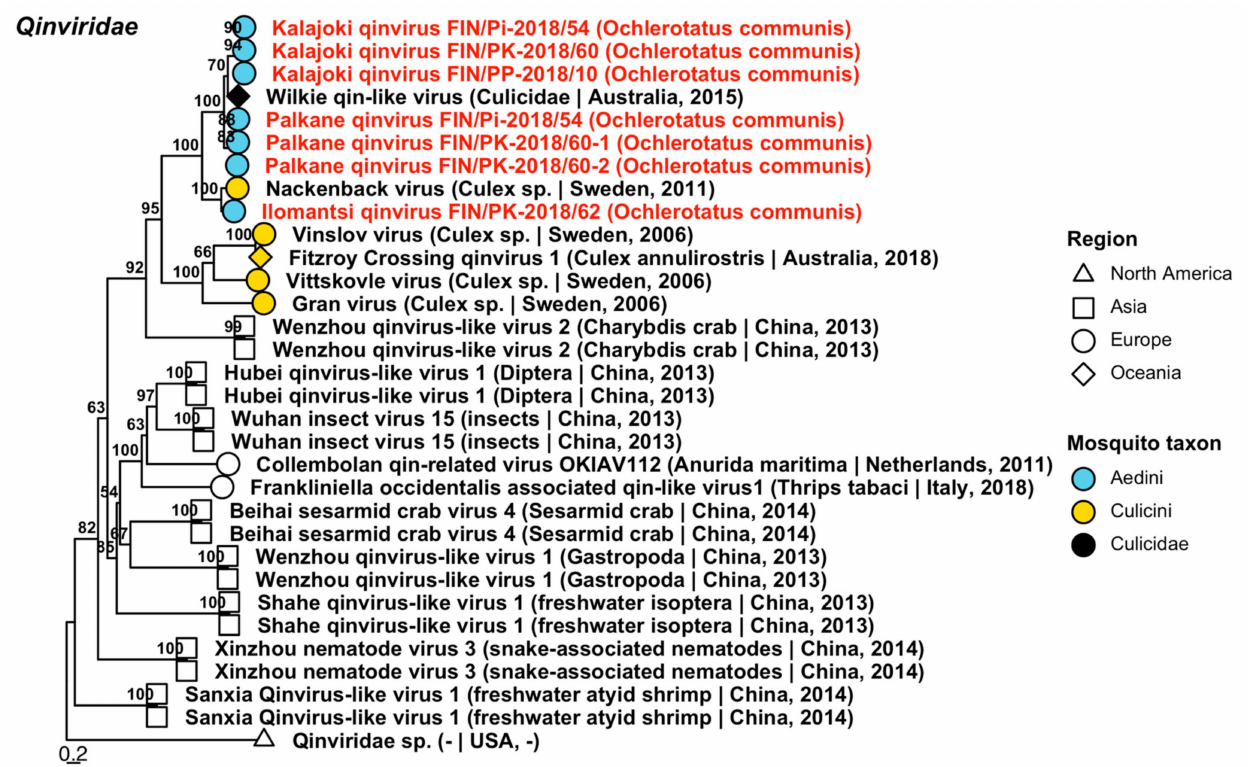
Figure 13. Maximum likelihood tree of Qinviridae . Tentative novel viruses are displayed in red and the mosquito species from which they were derived are in parentheses. Sequences from GenBank are black and display the following information after the virus or species name: “(sampled organ- ism(s)|collection country, collection year)”. Tip colours represent the tribe of mosquito from which viruses were obtained. Tip shape represents the continent or region from which the specimens were collected. Trees were constructed from amino acid sequences of virus polymerases >1000 nt, aligned with MAFFT and computed with IQ-TREE2 using ModelFinder and 1000